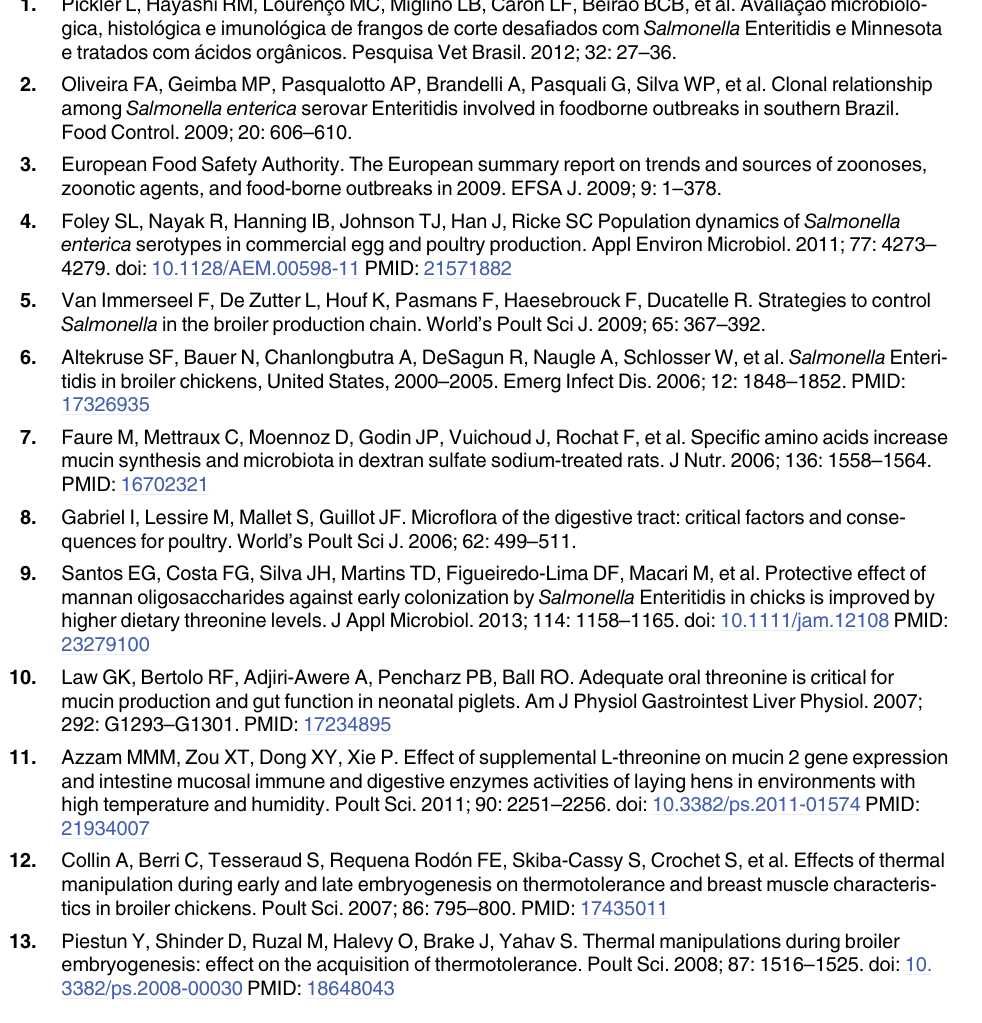
S3 Table. Effect of embryonic thermal manipulation on incubation parameters and weight of chicks at